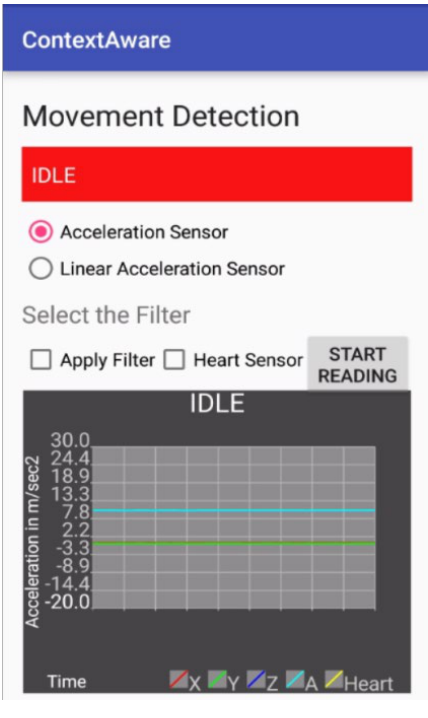
Figure 3 . Application for data collection & Noise Removal